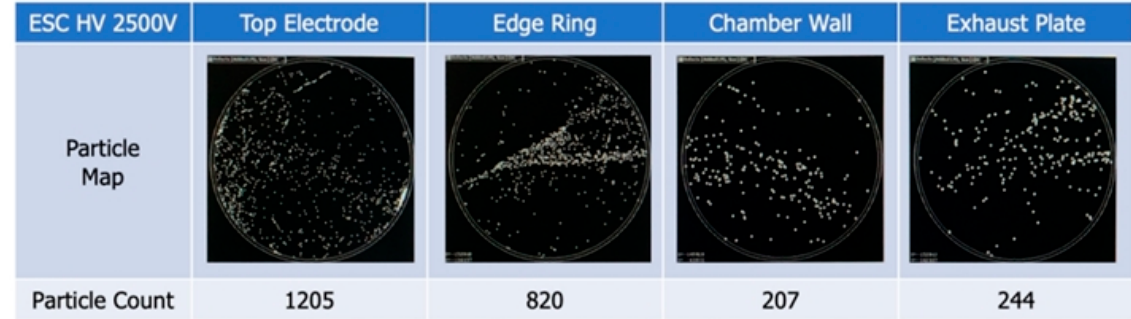
Figure 7. Particle distribution on the wafer in each chamber part when the ESC voltage was 2500 V.